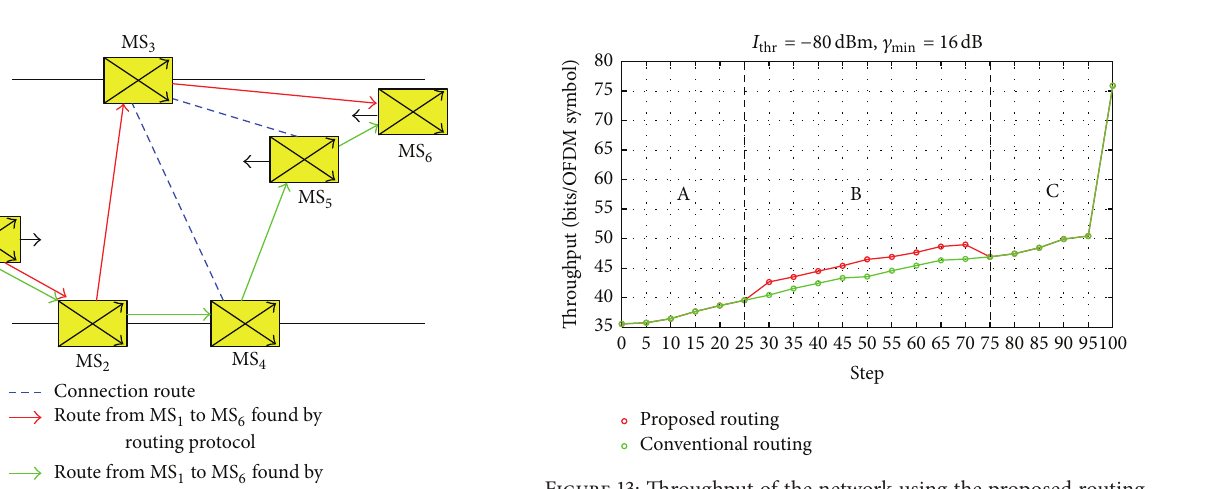
Figure 13: Throughput of the network using the proposed routing protocol and the conventional routing